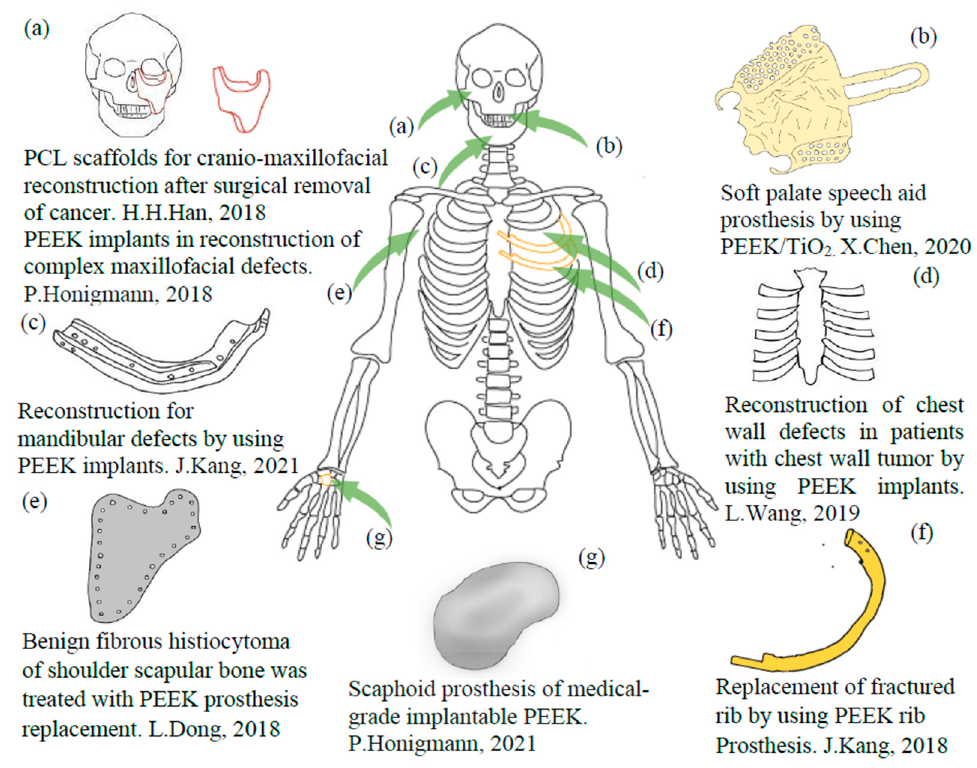
Figure 4. Summarized depiction of clinical applications reported in the studies reviewed in this paper. (For interpretation of the references to color in this figure legend, the reader is referred to the web version of this